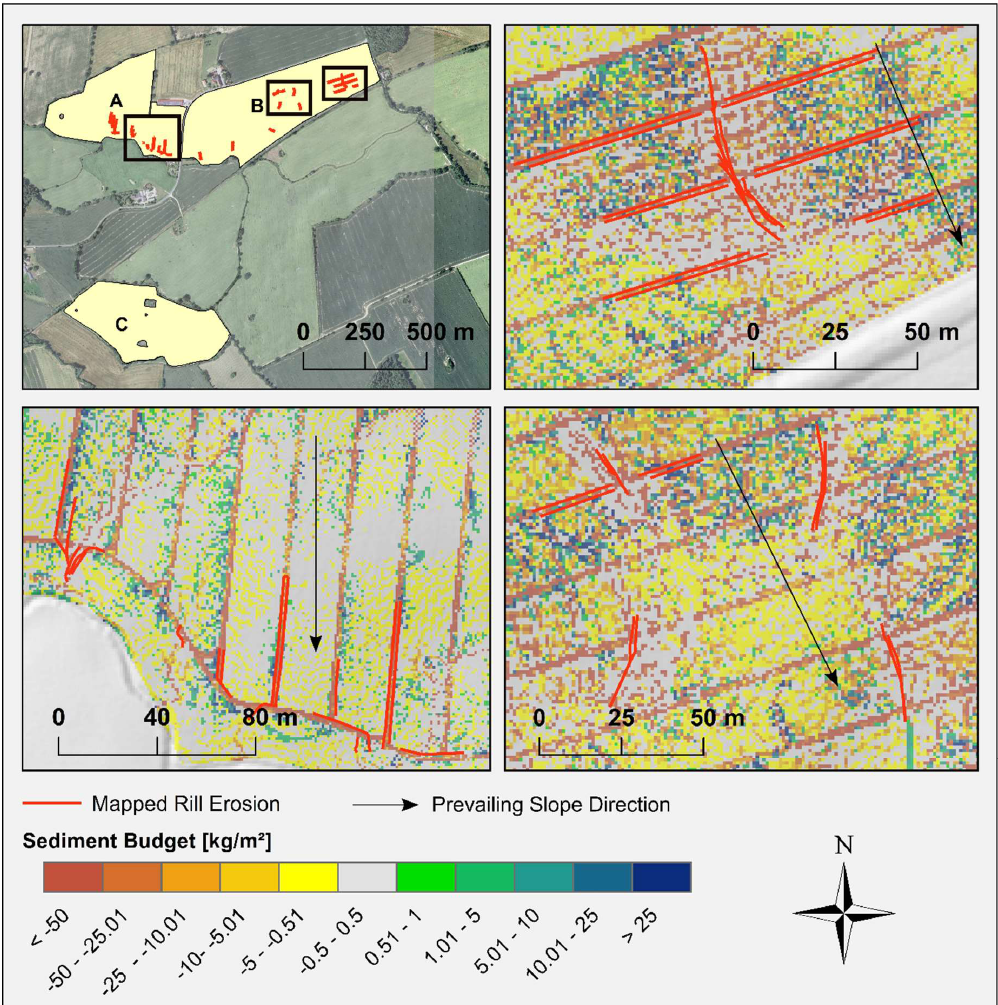
Figure 8. Exemplary representation of mapped rill erosion against modelled soil erosion (1 × 1 m cell size—TLS) for three different erosion hot spots (Field A and B). size—TLS) for three di ff erent erosion hot spots (Field A and